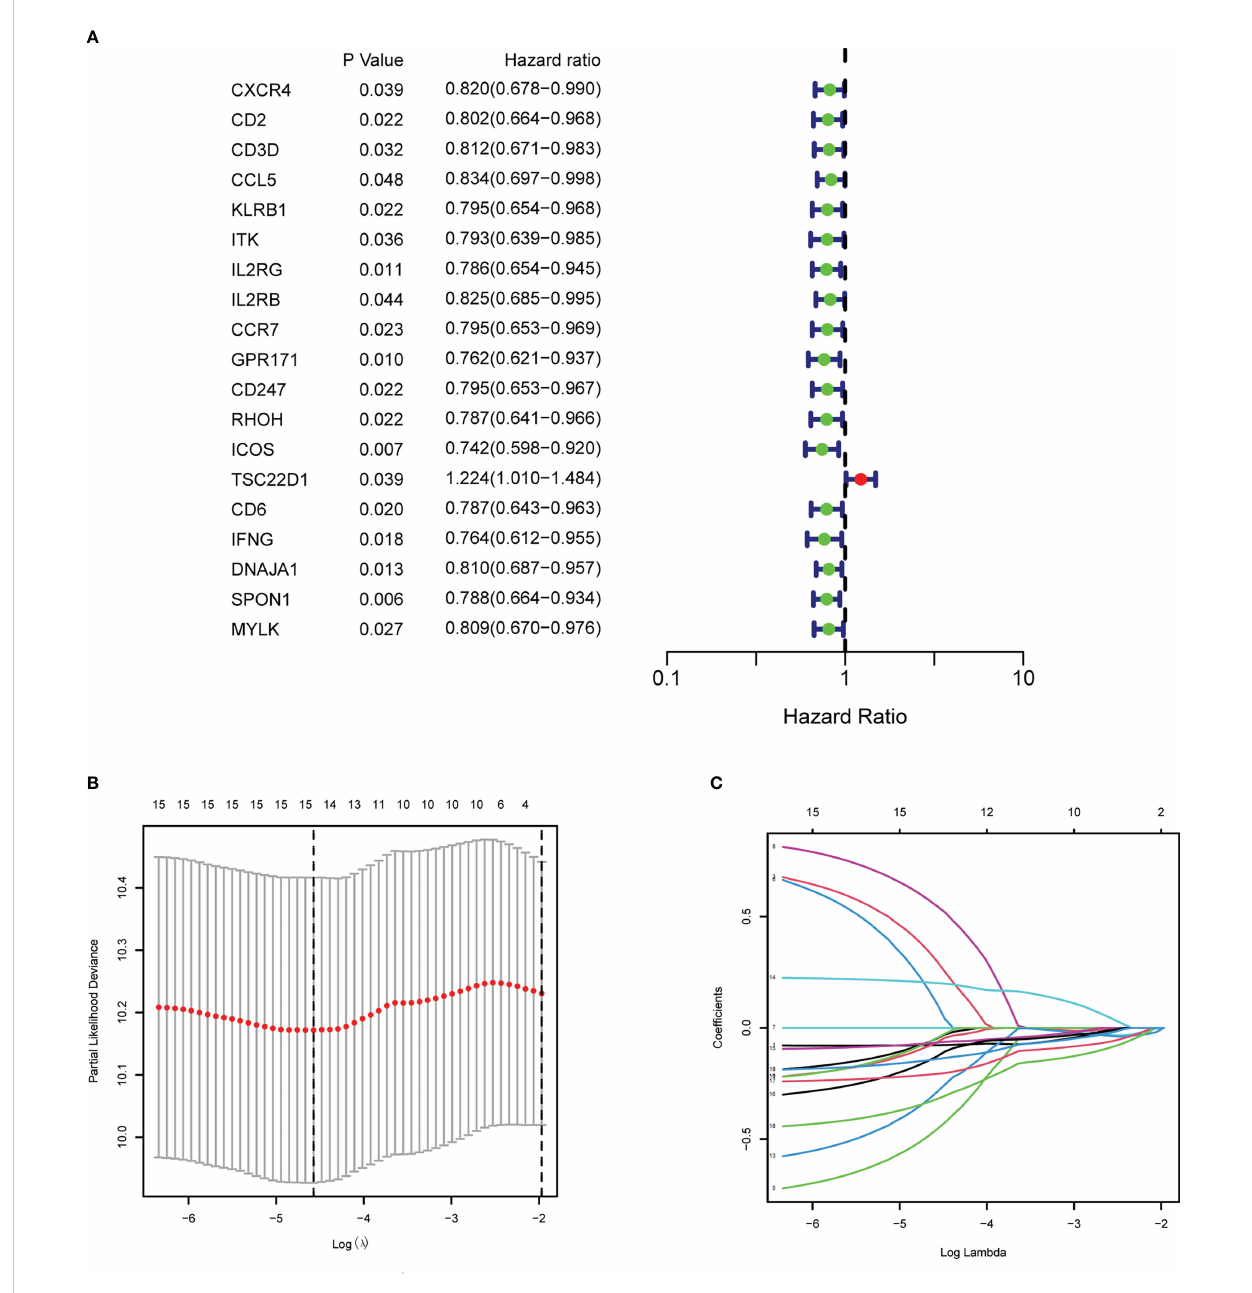
FIGURE 4 Establishment of the CD4+ conventional T cells-related genes signature in ovary cancer. (A) Prognosis-associated genes were extracted by univariate Cox regression analysis. (B) Ten-fold cross-validation for variable selection in LASSO regression analysis. (C) LASSO coef fi cient pro fi le of candidate